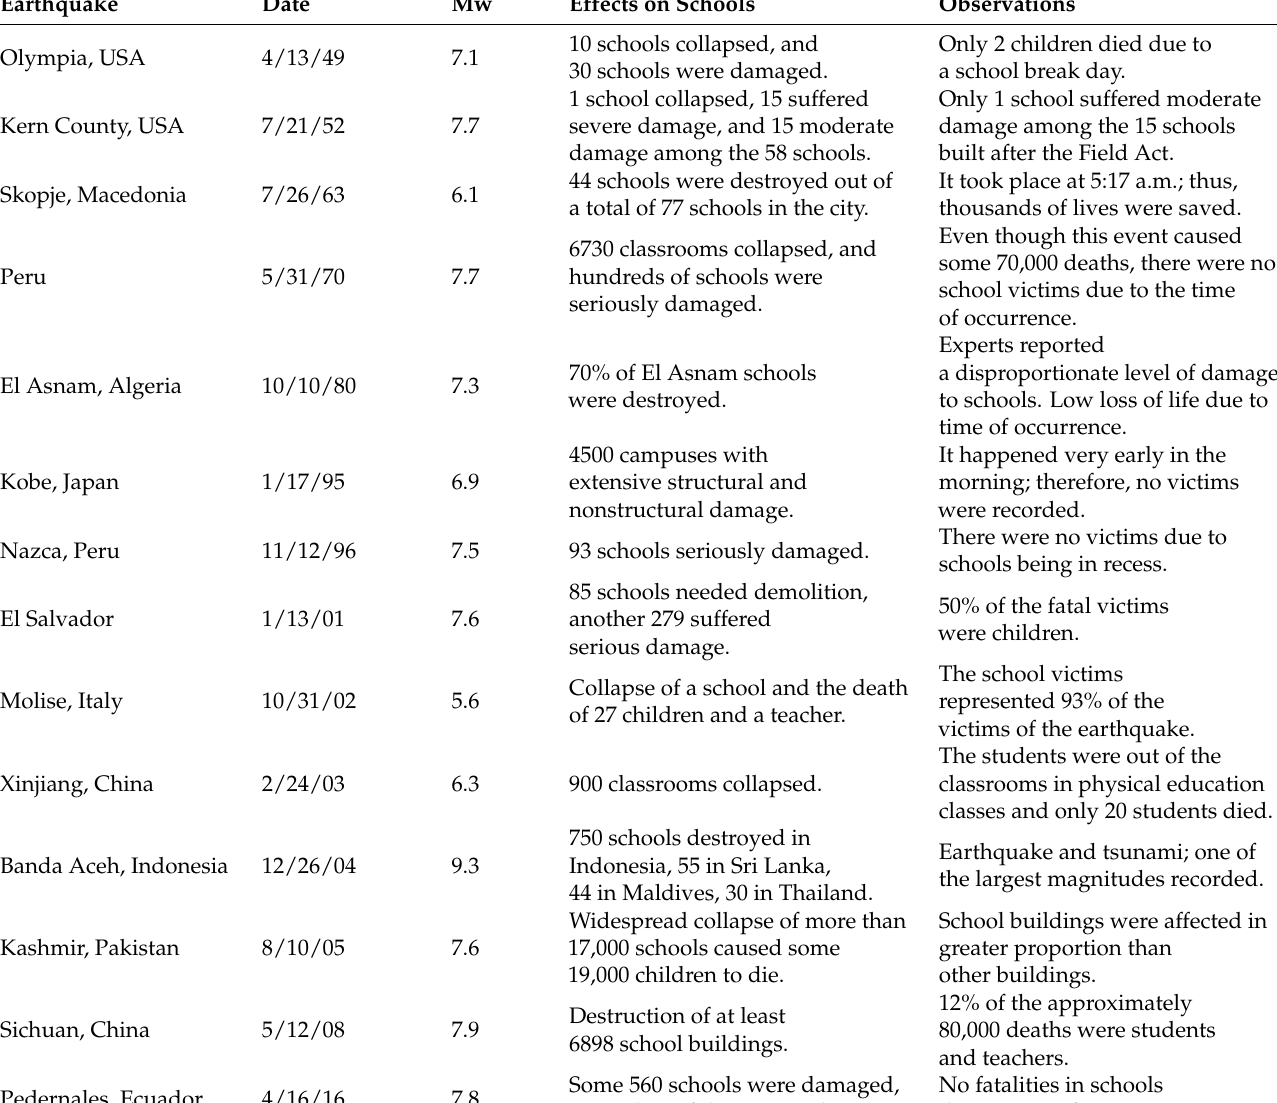
Table 1. Destructive effects on school buildings by selected earthquakes in the